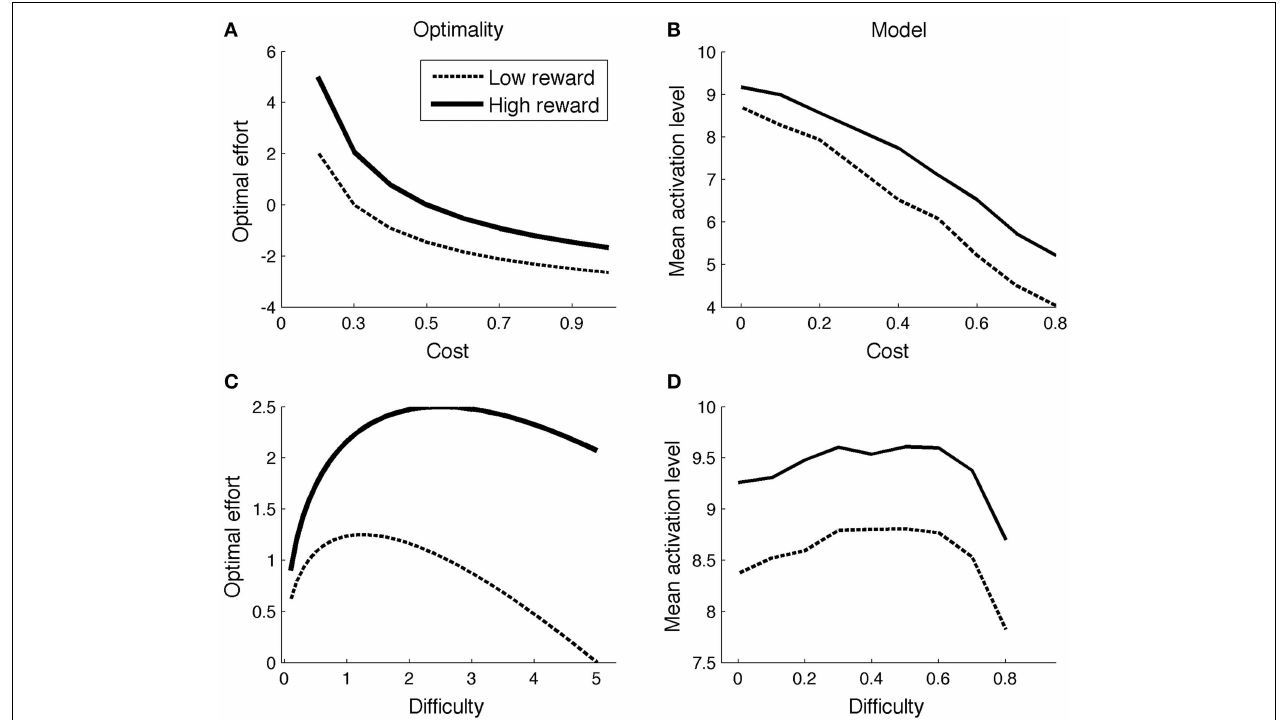
FIGURE 1 | Comparison of optimality perspective (A,C) and Simulation 1 (B,D).